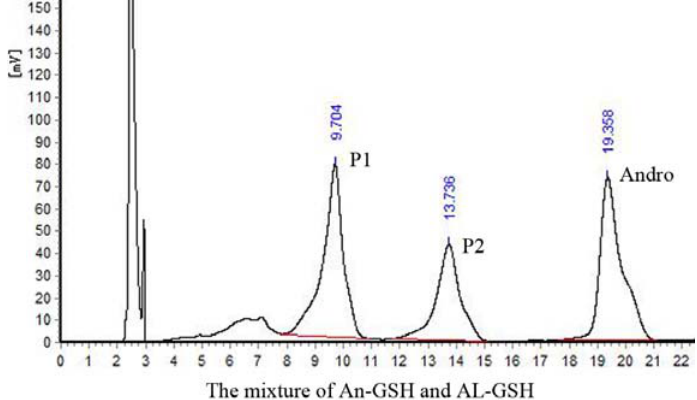
Figure 5. HPLC chromatogram of the mixture of An-GSH and AL-GSH reaction mixture. The mixture was analyzed by the mobile phase (2) methanol and 0.1% v/v TFA solution (40:60,